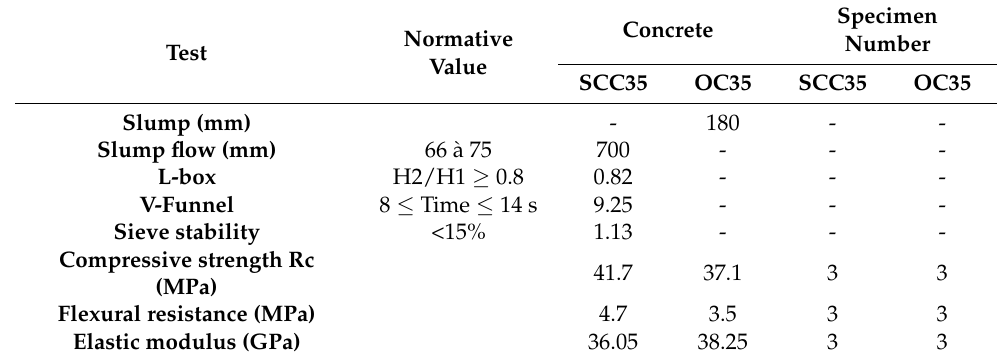
Table 7. Properties of concrete before thermal treatment.